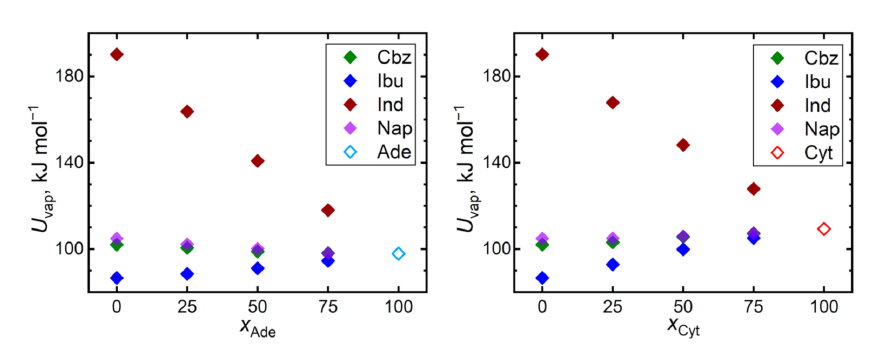
Figure 8. Vaporization energy U vap required to evaporate 1 mole of the given liquids at 410